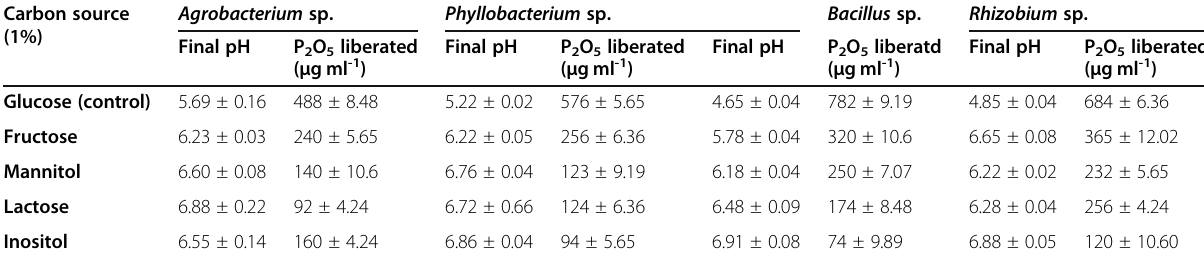
Table 3 Effect of different carbon sources on the tricalcium phosphate solubilization by the tested rhizobacterial strains Carbon source (1%)